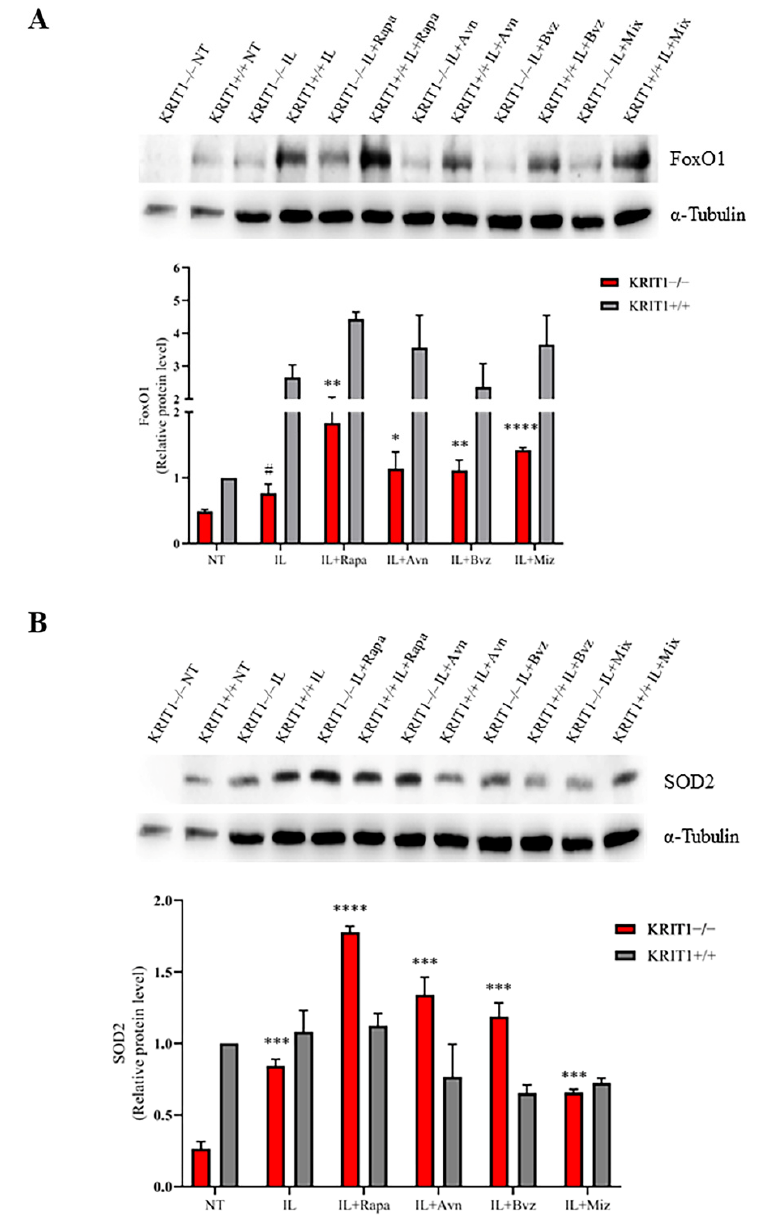
Figure 2. ( A ) Immunoblot analysis and representative histogram of the oxidative stress marker fork- head box class O1 (FoxO1) in KRIT1-knockout (KRIT1 − / − ) and KRIT1-overexpressing (KRIT1+/+) mouse embryonic fibroblasts (MEFs) untreated (Ctrl) or treated for 24 h with injectable nanoemul- sions (ILs) loaded with rapamycin (Rapa), bevacizumab (Bvz), yeast avenanthramide I (Avn), or with a combination of all three compounds (herein referred to as Mix) to a final concentration of: Avn = 15 µg/mL (50 µM), Rapa = 0.46 µg/mL (500 nM), Bvz = 10 µg/mL (70 nM). After treatment, cells were lysed, as described in Materials and Methods, and analyzed for the indicated proteins by Western blot (WB) analysis. ( B ) Immunoblot analysis and histogram representing the quantitative evaluation by densitometric analysis of superoxide dismutase 2 (SOD2) protein expression levels. Quanti fi cations are relative protein level units referring to the average value obtained for KRIT1+/+ samples. α -tubulin was used as internal loading control for WB normalization. Statistical analysis: treatments vs. NT in KRIT − / − MEFs: # p < 0.1; * p < 0.05; ** p > 0.01; *** p < 0.005; **** p < 0.0001.